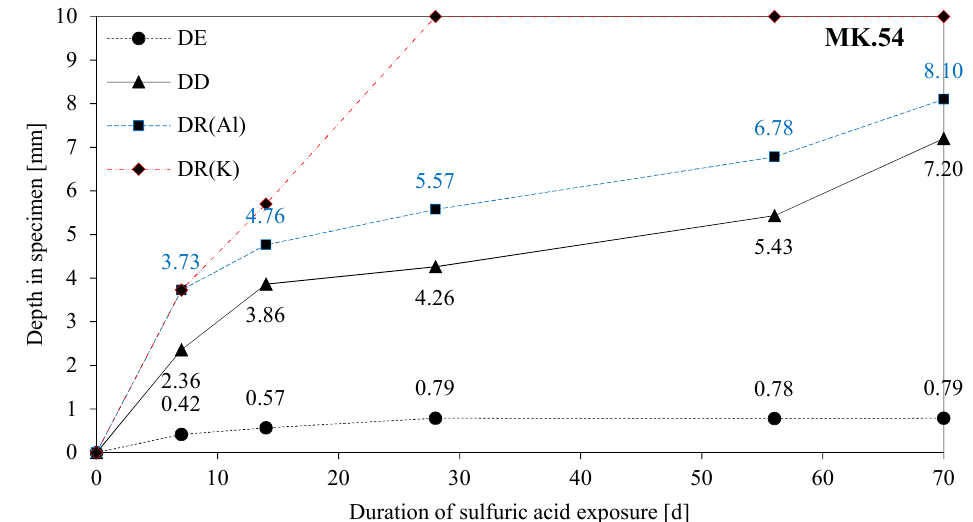
Figure 16. DE (depth of erosion), DD (depth of deterioration), and depth of reaction of aluminum (DR(Al)) and potassium (DR(K)) for MK54, as a function of the duration of exposure in sulfuric acid.